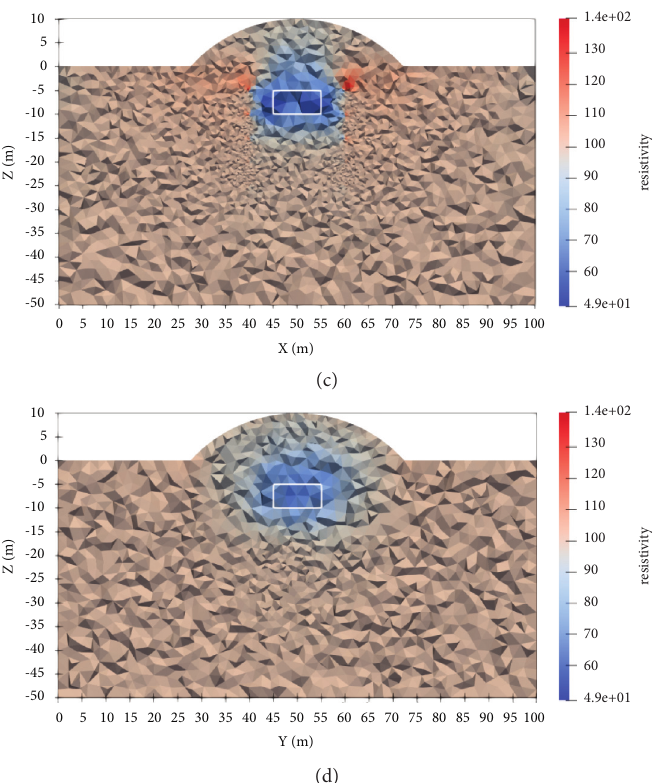
Figure 14: Inversion results of anomalous bodies under mountain topographical model. (a) The change in the relative RMS during the inversion process; (b) slice of resistivity 3D inversion result; (c) slice of resistivity inversion result at XOZ profile; (d) slice of resistivity inversion result at YOZ profile. The outline of the true model is indicated by the white